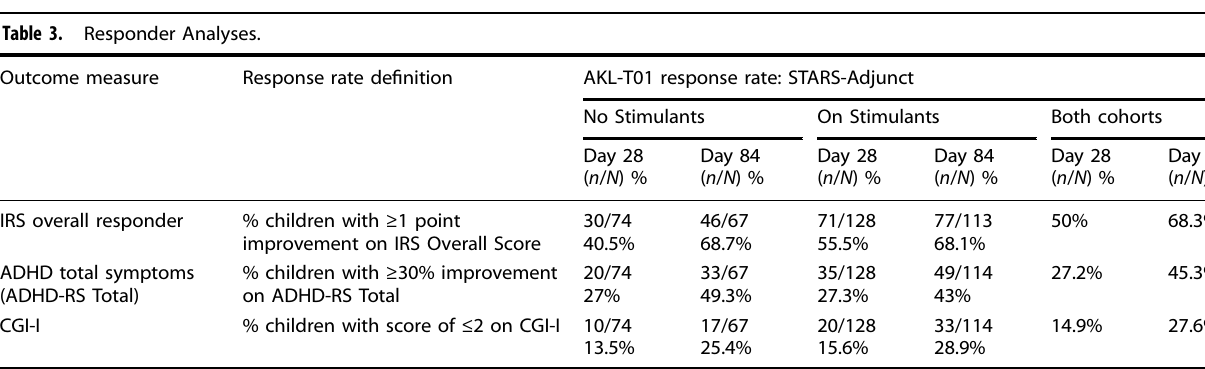
Table 3. Responder Analyses.